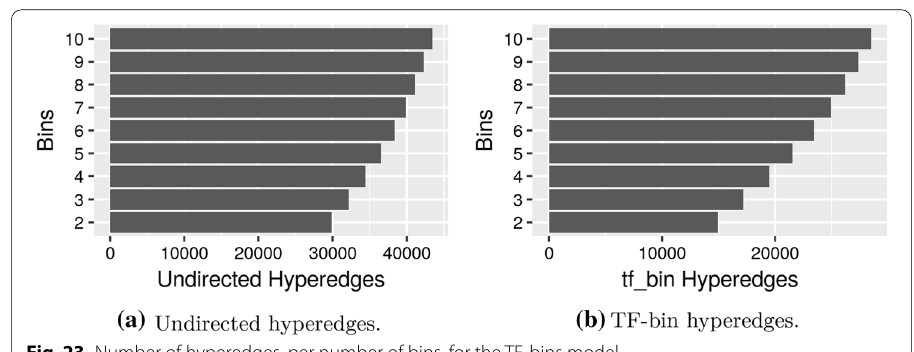
Fig. 23 Number of hyperedges, per number of bins, for the TF-bins